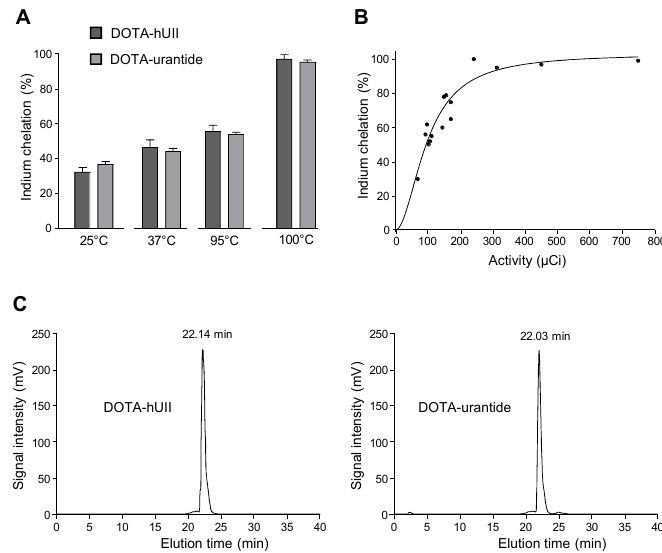
Figure 2. Radiolabelling of DOTA-hUII and DOTA-urantide with 111 Indium. The labelling of DOTA- hUII and DOTA-urantide with 111 In was performed in isocitrate buffer (pH 4, 20 min). ( A ) Determination of the optimal temperature for indium chelation. DOTA-analogues were incubated at 25 °C, 37 °C, 95 °C or 100 °C. ( B ) Relationship between initial activity of 111 In and chelation of DOTA- hUII. ( C ) HPLC profiles of 111 In-DOTA-hUII (left) and 111 In-DOTA-urantide (right). The retention time of DOTA-hUII and DOTA-urantide, was 22.14 and 22.03 min, respectively. Table 1. Stability of 111In-DOTA-hUII in human plasma. After incubation in human plasma (until 3 h, 37 °C), the stability of radiolabelled DOTA-hUII was analysed by HPLC. Time in Plasma Percent of Radiolabelled Peptide